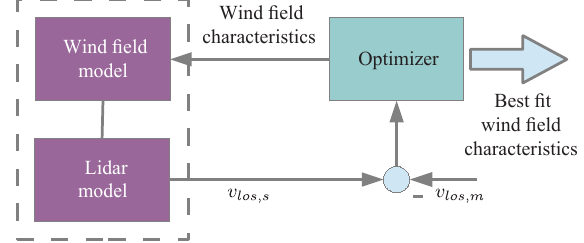
Figure 4. The submodels of the wind field model (in the wind coor- dinate system W ): (1) the underlaying wind field and (2) the wake model.